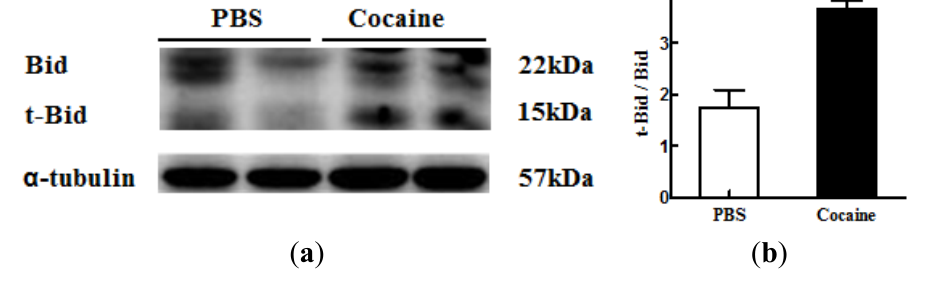
Figure 3. ( a ) The representative protein products of BH3 interacting domain death agonist (Bid), truncated Bid (t-Bid) extracted from the left ventricles of excised hearts in 2 Wistar rats with PBS exposure (PBS), 2 Wistar rats with cocaine exposure (Cocaine) as measured by Western blotting analysis. α -tubulin was used as an internal control; ( b ) Bar represents the ratio of t-Bid to Bid and indicates mean values ± SD ( n = 6 in each group). * p < 0.05, significant difference between PBS and